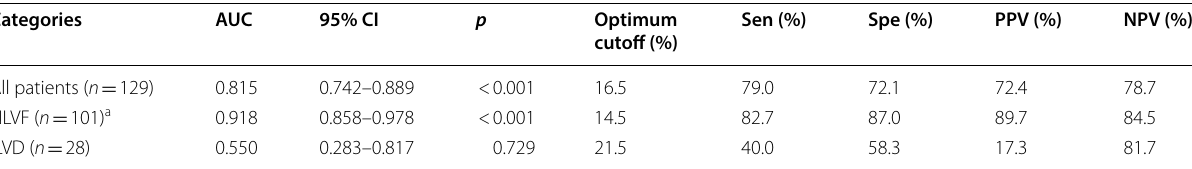
NLVF normal left ventricular function, ILVD isolated left ventricular systolic dysfunction, dIVC inferior vena cava distensibility index, AUC area-under-the-curve, CI confidence interval, Sen sensitivity, Spe specificity, PPV positive predictive value, NPV negative predictive value a In comparison with AUC derived from all patients, p =